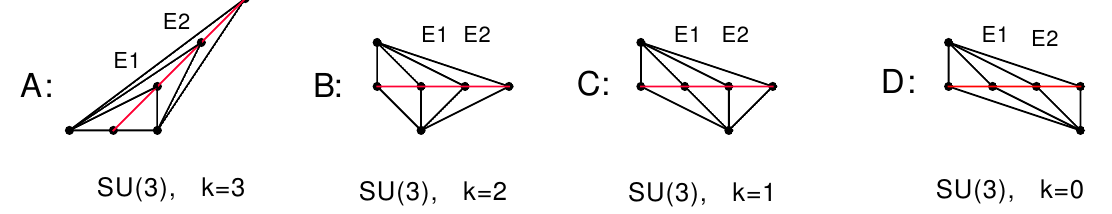
Figure 10 . Four toric diagrams with their partial crepant resolutions. We also write down the gauge theory descriptions.